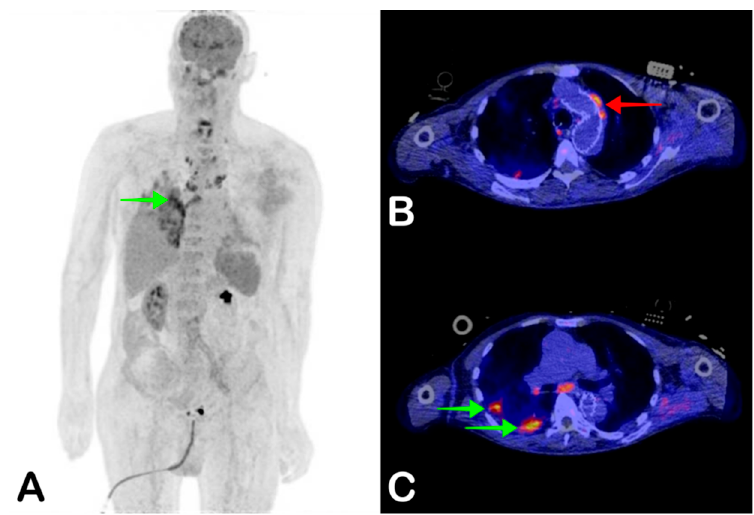
Figure 4. A 72-year-old man with a vascular graft in the aortic arch, abdominal aorta, and left common iliac artery was admitted with a fever of 38.5 degrees Celsius. Blood cultures were positive for Enterococcus faecalis. A clinical diagnosis of endocarditis was made based on the modified Duke criteria, although transthoracic and transesophageal ultrasound did not show signs of endocarditis. Coronal maximum-intensity projection FDG-PET showed increased FDG uptake in the right lower pulmonary lobe suggestive of infection ( A , green arrow), and multiple metabolically active mediastinal and paratracheal lymph nodes. Fused axial FDG-PET/CT showed increased FDG uptake of the aortic arch stent suggestive of infection ( B , red arrow), as well as FDG avid lesions suggestive of pulmonary infection ( C , green arrows). The patient died three days after the PET/CT.